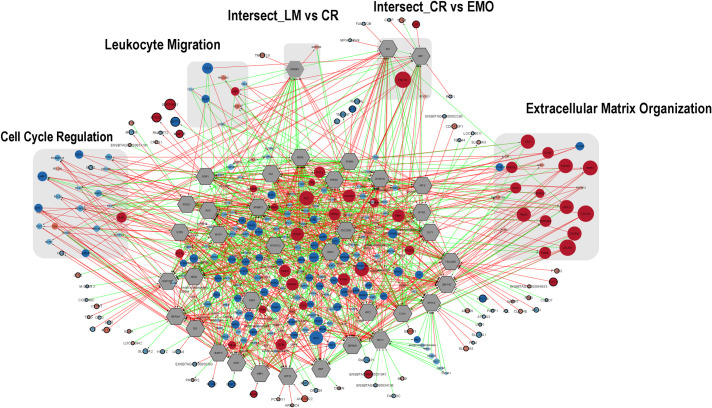
Meaningful gene-gene associations in co-expression networks of LPS stimulated MDM from Holstein and Gir breeds emphasizing ontology-based differential frameworks enrichment analysis.Network displaying differential interactions among DEGs of MDMs in Holstein (n = 4) and Gir (n = 4) breeds after co-expression analysis using CeTF and Diffany Cytoscape plugin. Red edges indicate decreased connections in Gir network compared to Holstein LPS stimulated MDMs after 48 hours. Green edges indicate increased connections in Gir network compared to Holstein MDMs in the same condition. Gray hexagonal nodes indicate key transcriptional factors (KeyTF) obtained after PCIT/RIF analysis in CeTF (Bioconductor package). Circular red nodes indicate up-regulated genes while blue nodes indicate downregulated genes found in comparison of MDMs from Holstein and Gir breeds stimulated with LPS and enriched after PCIT/RIF analysis. Lighter and darker hues, as well as the size of the circle, are associated to representativeness of gene expression in the analyses. Genes that displayed unique interaction with KeyTF are highlight by thicker edges. The key ontologies related to Biological Processes differently enriched for Holstein and Gir breeds after co-expression analyses are highlight in grey boxes. LM: Leukocyte Migration; CR: Cell Cycle Regulation; EMO: Extracellular Matrix Organization; Intersect: Genes enriched for more than one process highlighted by co-expression analysis. Genes not related to any Biological process but detected in RIF/PCIT/Dyffany analyses were grouped in the middle of the figure. All statistical analyses were performed according to software and plugin default parameters and significance thresholds were P<0.001 and FDR<0.05.